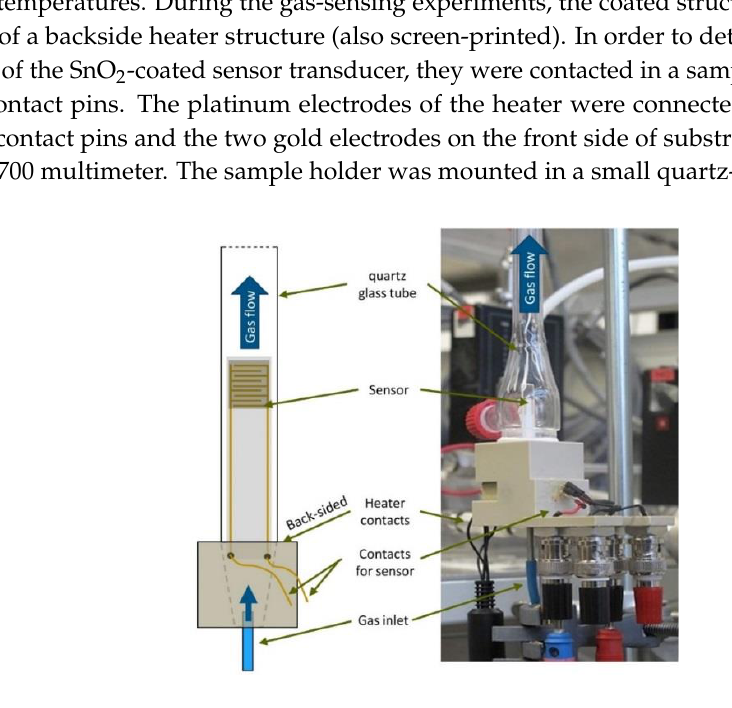
Figure 1. Gas sensor test rig and setup as schematic ( left ) and image ( right ): Sample in sample holder with sealed glass tube, gas inlet, outlet and electrical contacts for heating and electrical measurement.